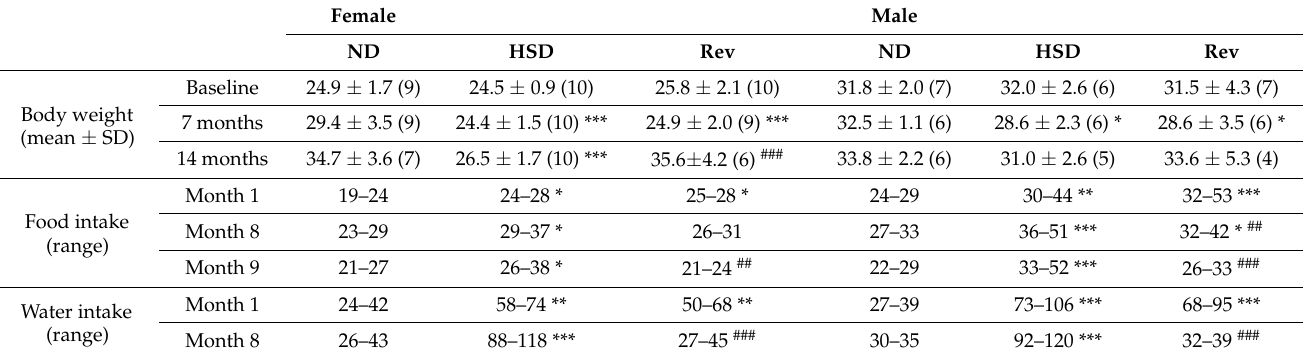
Figure 1. Exposure to high-salt diet (HSD) during aging leads to lower cortical and hippocampal perfusion in mice, which recover upon normalization of dietary salt intake. ( a ) Study design for diet intervention over 14 months. ( b ) Representative cerebral blood flow (CBF) maps measured by ASL-MRI from mice fed with normal diet (ND) or HSD for 14 months, or HSD followed by diet normalization (Rev). ( c , d ) Mean cortical ( c ) and hippocampal ( d ) CBF at baseline, before diet normalization (i.e., 7 months) and at the end of the study (i.e., 14 months), as measured by ASL-MRI (n = 9–10). Data are means ± SDs. Symbols overlaid on bars represent independent measurements from each mouse. * p < 0.05, ** p < 0.01, *** p < 0.001, a p = 0.065 compared to ND or as indicated using Fisher LSD tests after significant effects of diet were determined by two-way ANOVA. Table 1. Body weight (g) and cage average weekly consumption of food (g/mouse/week) and water (mL/mouse/week). Number of mice is given in parenthesis. * p < 0.05, ** p < 0.01, *** p < 0.001 vs . ND; ## p < 0.01, ### p < 0.001 vs . HSD.